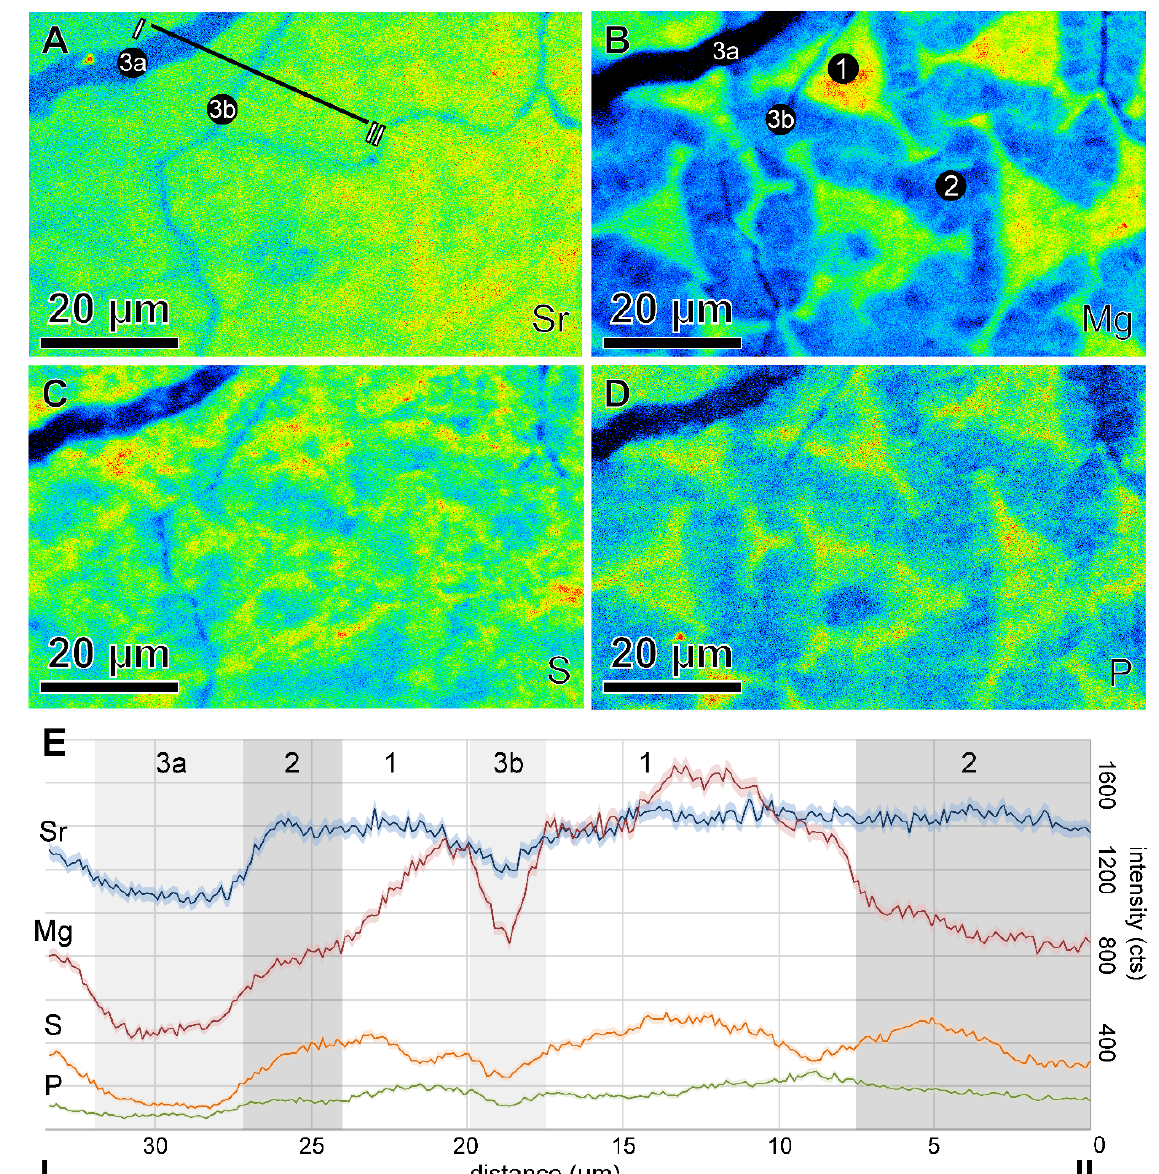
Figure 2. X-ray element distribution maps acquired using electron microprobe (EPMA). ( A ) Distribution of Sr with slightly higher counts in CP2 and significant lower counts in the late diagenetic calcite (3a and 3b) filling the larger crack. ( B ) Distribution of Mg is heterogeneous with higher counts in the biogenic skeleton (CP1) compared to CP2. ( C ) Counts for S are similarly distributed as Mg. ( D ) Distribution of P parallels the pattern Mg. ( E ) Counts of all four elements along the profile I–II. Note: Bluish colors correspond to lower X-ray intensity, and warmer yellow-red colors, to higher x-ray intensity (numbers in ( B ) refer to Figure 1; confidence bands are given as 1 σ ).